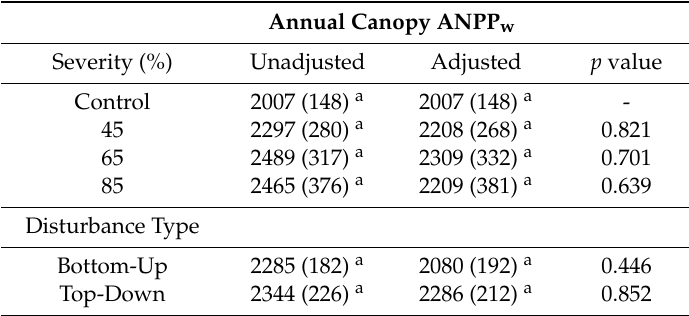
Table A4. Annual upper canopy (DBH ≥ 8 cm) aboveground wood net primary production (ANPP w ) values unadjusted for swelling and adjusted for Acer rubrum DBH swelling (30 cm) above girdled tissue. Dendrometer bands (N = ≥ 3 per species) were fitted to stems at two heights 50 cm apart and their diameter increments recorded concurrently on five occasions between July 2019 and November